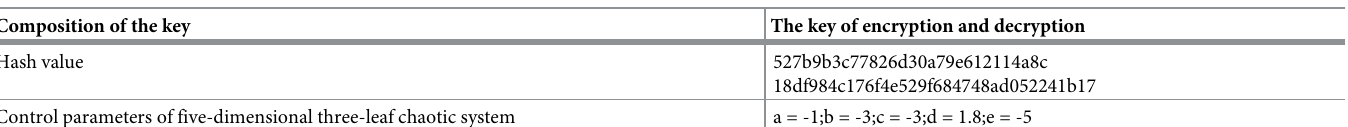
Table 11. Key table of this algorithm. Composition of the key The key of encryption and